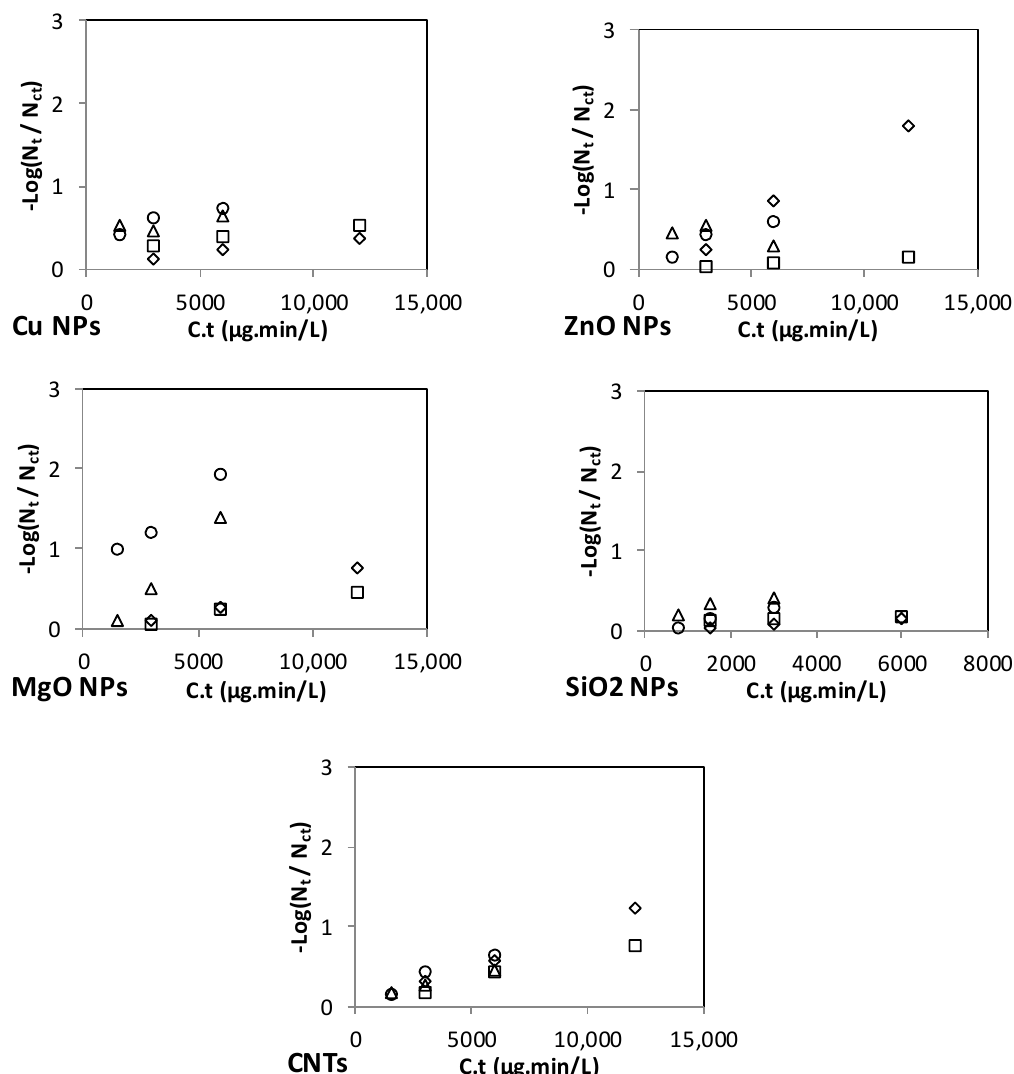
Figure 4. Effect of C.t on the inactivation of E. coli , Enterococci , Enterobacter , and Salmonella in the spiked MSF distillate.